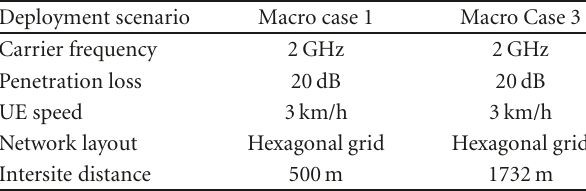
Table 3: 3GPP LTE deployment scenarios.